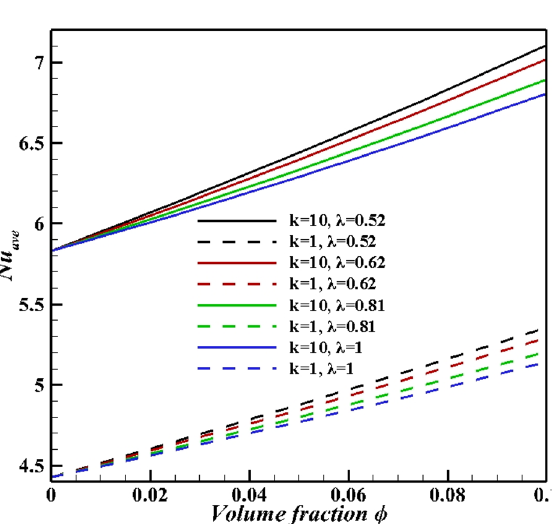
Figure 16. Average Nusselt number for different Raleigh numbers, dimensionless angular velocities, and thermal conductivity ratios at Ha = 60, = 0.05, and λ = 0.52. ϕ